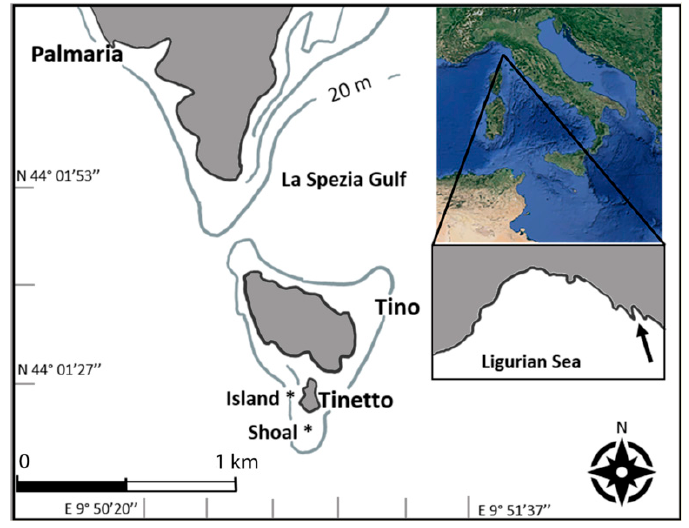
Figure 1. Sampling area, Tinetto islet: stars represent the sampling sites (Eastern Liguria Sea, NW Mediterranean, Italy).